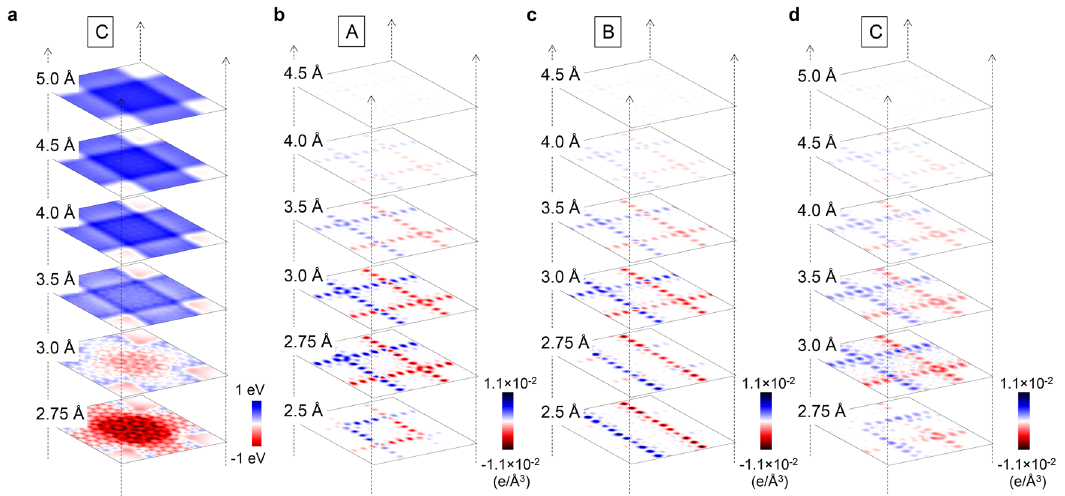
Fig. 5 | Calculated electrostatic potential distribution and spin density dis- tribution. a Electrostatic potential distribution in the middle plane between TBZGNRs as a function of interlayer distance (based on Model C). Blue and red colourscorrespond to positive and negative values, respectively. b – d Spin density